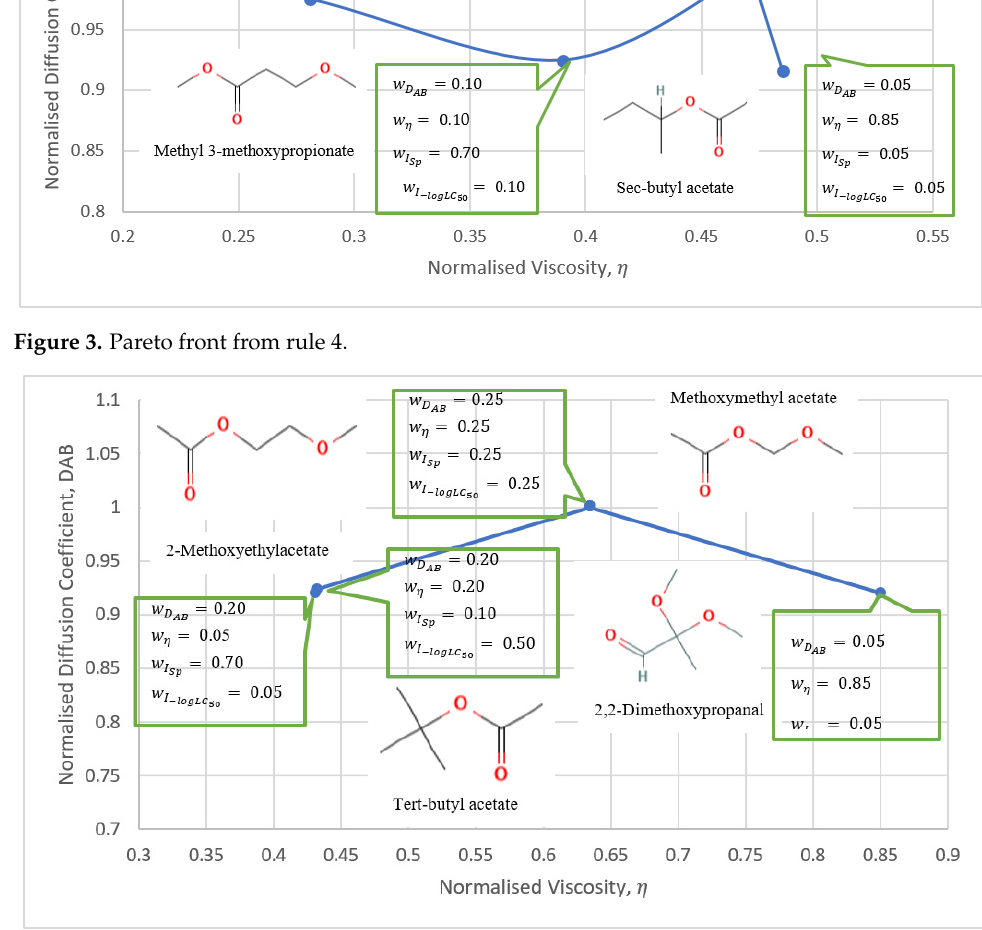
Figure 4. Pareto front from rule 18.